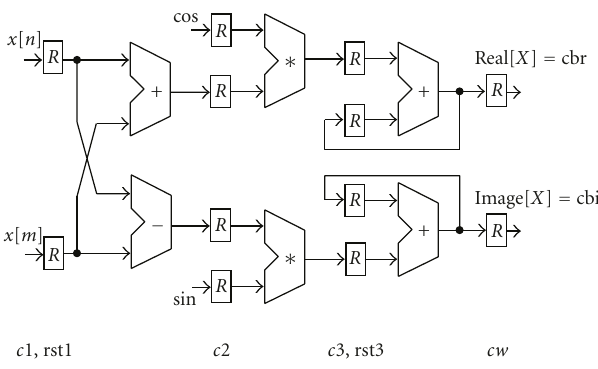
Figure 5: Proposed pipelined CBT data